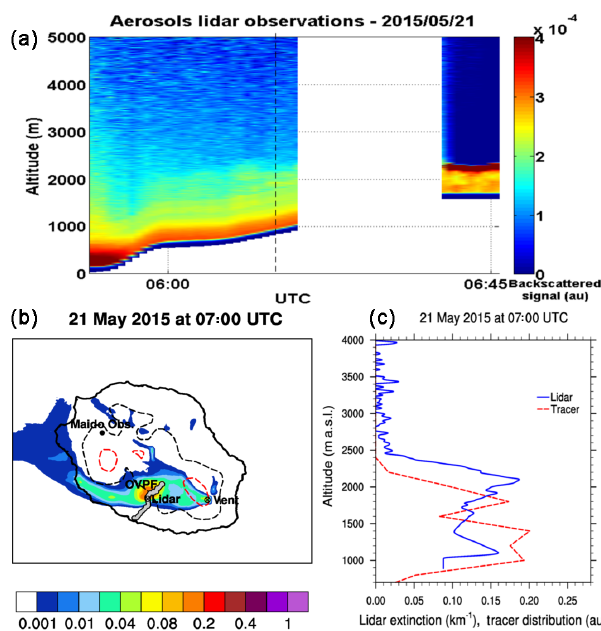
Figure 9. (a) Backscattered signal (arbitrary unit) along the 21 May pick-up truck’s track (grey line on the bottom left panel). The black dashed line shows the profile used to retrieve the extinction pro- file shown in the bottom right panel. (b) FLEXPART simulation of the volcanic tracer load modelled on 21 May at 06:00UTC and the trace of the pick-up truck path (grey line). (c) Aerosols extinction profile retrieved on 21 May 2015 06:14UTC (blue line) and tracer profile simulated by FLEXPART at the same location at 06:00UTC (dashed red